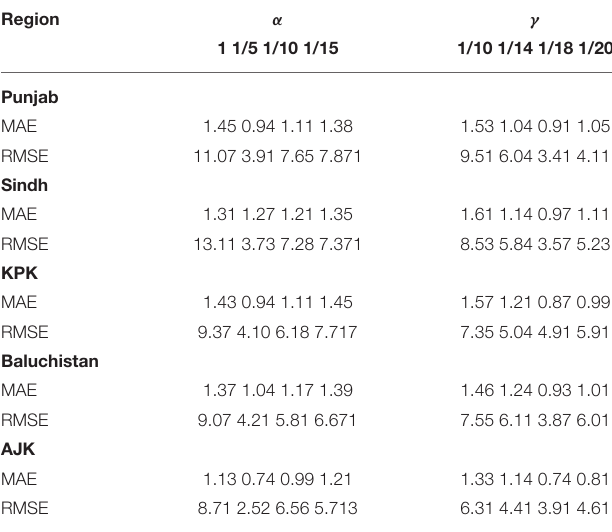
TABLE 6 | Determination of the impact of seven parameters.